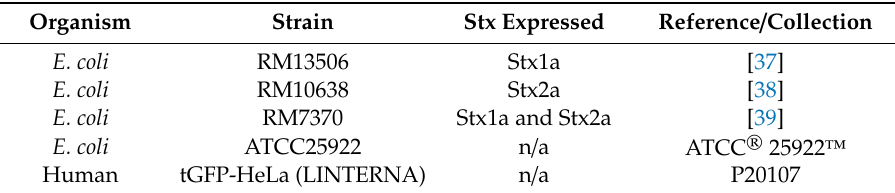
Table 2. Strains used in this study.